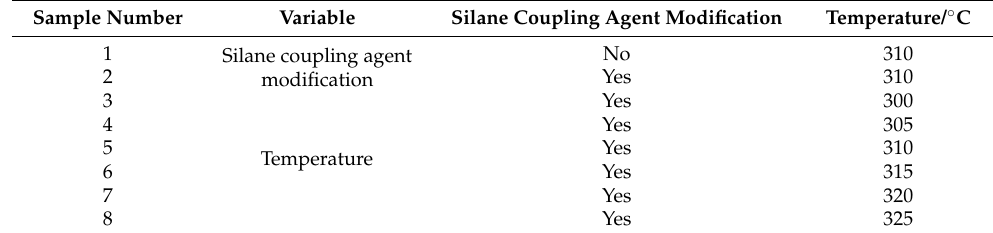
Table 2. Experimental parameters for composite preparation.